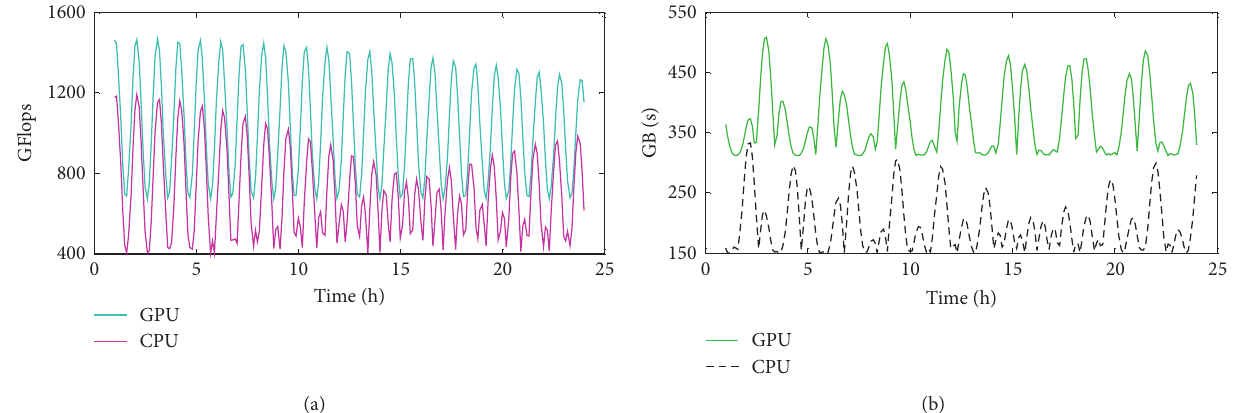
Figure 5: GPU and CPU performance comparison chart. (a) Comparison of double-precision floating-point number calculation per- formance. (b) Memory bandwidth comparison.